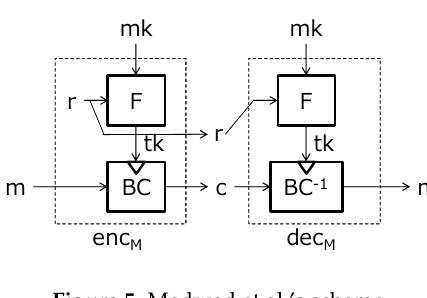
Figure 5. Medwed et al.’s scheme.